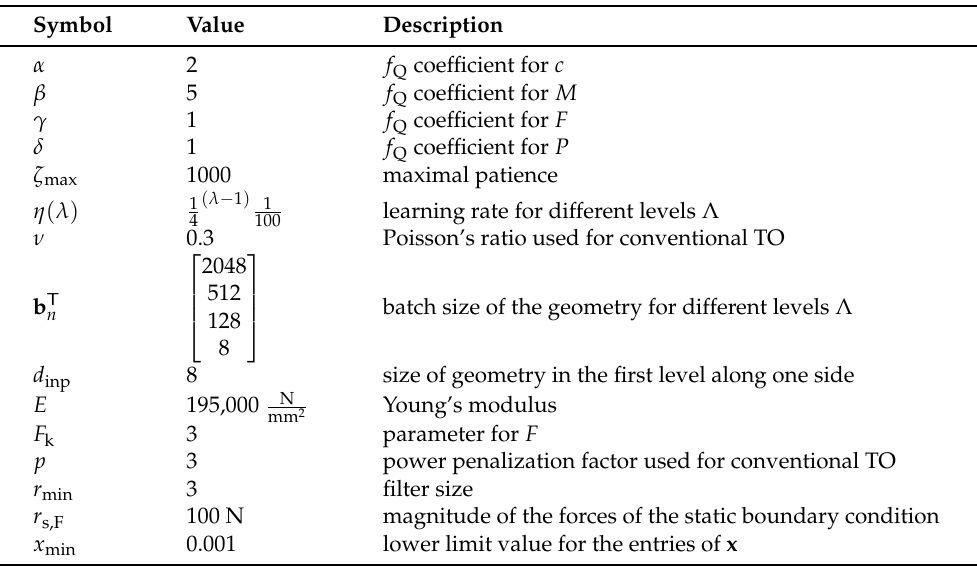
Table 2. Parameter used for training and generation of validation data.